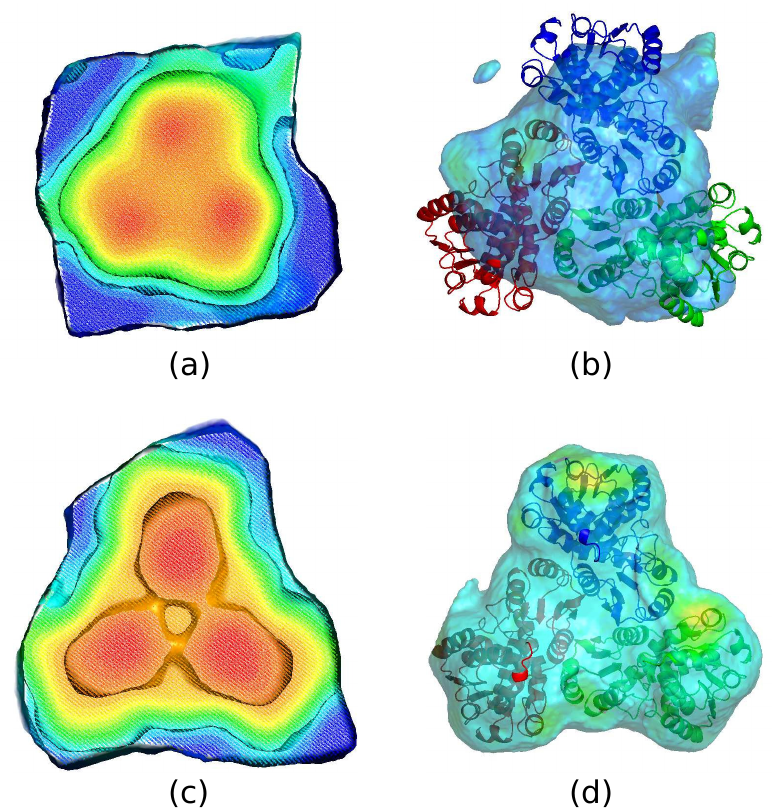
Figure 9. Evolution of the calculated core, ASU, and protein boundary of 4NF2 in a successful run. Warm colors represents high weighted average density. ( a , b ) Show the calculated center core, ASU, and protein boundary before a run reaches the solution. The inner shell shows the center core region. The outer shell corresponds to a complete asymmetric unit building from the core towards the gradient direction on a weighted average density map. The protein boundary shown as the middle shell is contained inside the calculated ASU. ( c , d ) Show the results after the run reaches the solution. The calculated protein boundary matches the PDB deposited model very well.